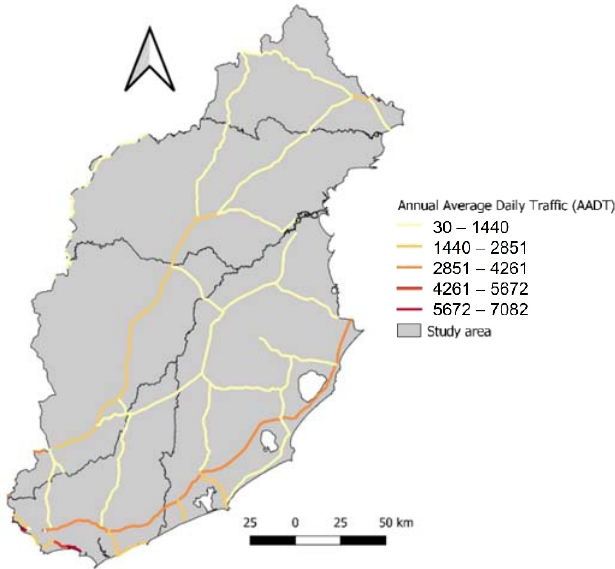
Figure 5. Map of Annual Average Daily Traffic (AADT) for the year 2017 obtained from the Min-